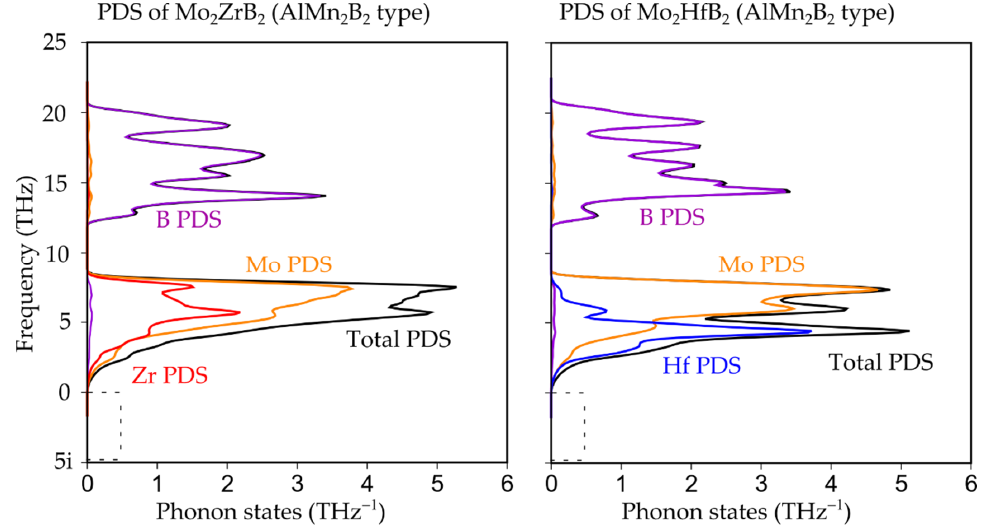
Figure 3. Phonon-Density-of-States (PDS) of Mo 2 ZrB 2 ( left ) and Mo 2 HfB 2 ( right ) both with AlMn 2 B 2 - type structure. The dashed boxes show that there are no imaginary phonon frequencies for Mo 2 ZrB 2 and Mo 2 HfB 2